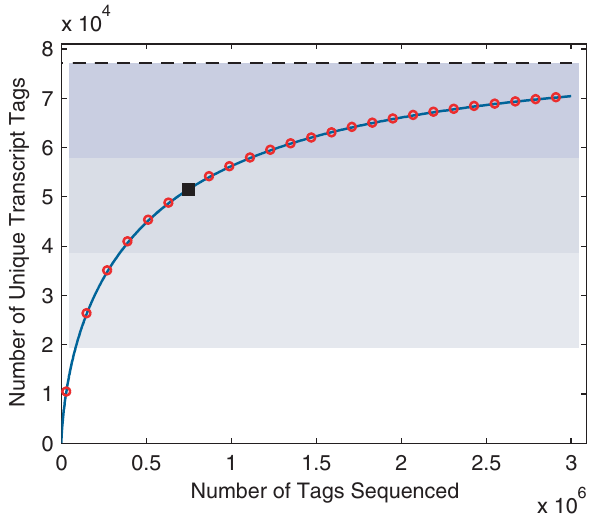
Figure 7. Monte Carlo simulation of a deep transcriptome sampling. Monte Carlo simulation is done with the fitted RAD and estimated transcriptome diversity S of the pooled library, for a deep sampling that ranges from 0 up to 3,000,000 with step length of 120,000. The predicted growth curve (blue solid line) aligns well with the simulation (red open circle). Both the simulated and the predicted growth curves intercept at the data point for the original library (solid square). Blue-shaded areas divide the estimated transcriptome diversity S (black dashed line) into four quarters.